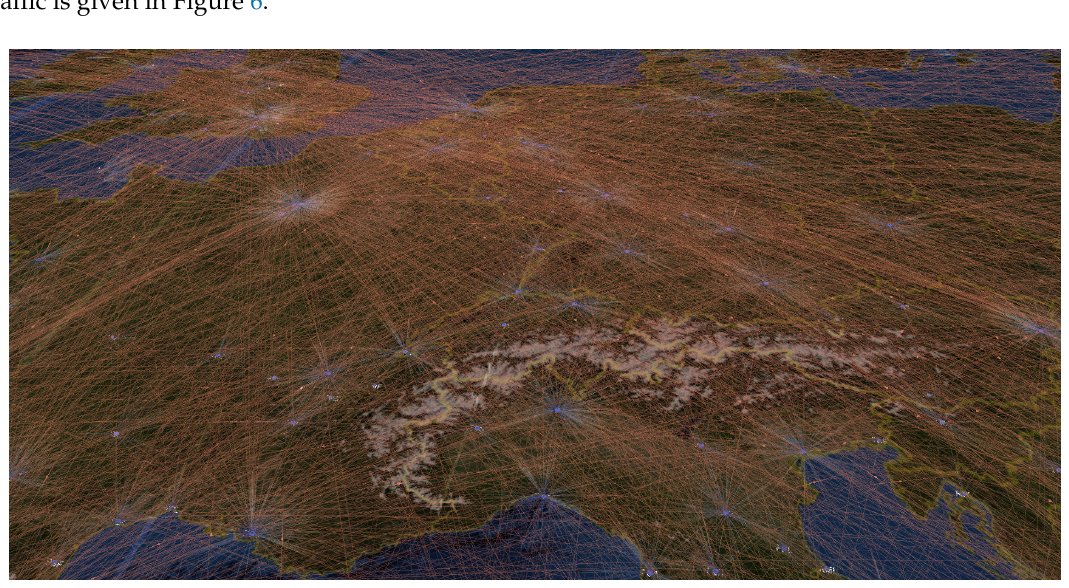
Figure 6. Traffic simulation before business trajectory